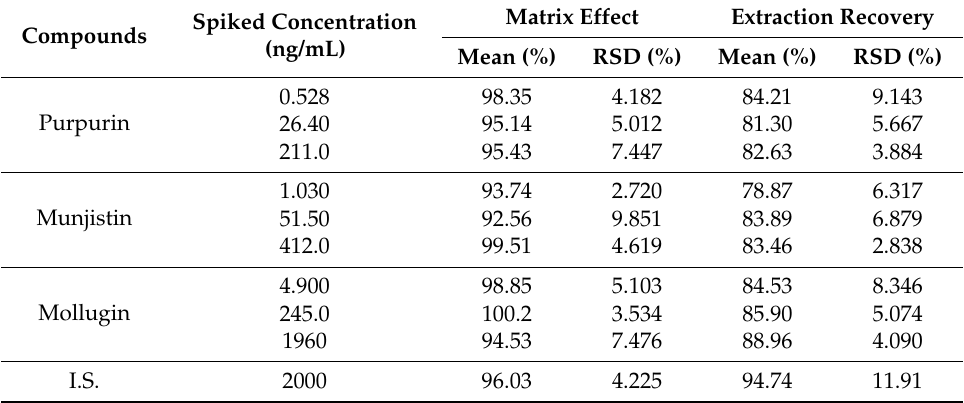
Table 4. Matrix effects and extraction recovery for the analytes in rat plasma ( n = 6). Matrix Effect Extraction Recovery Spiked Concentration Compounds (ng/mL) Mean (%) RSD (%) Mean (%) RSD (%)